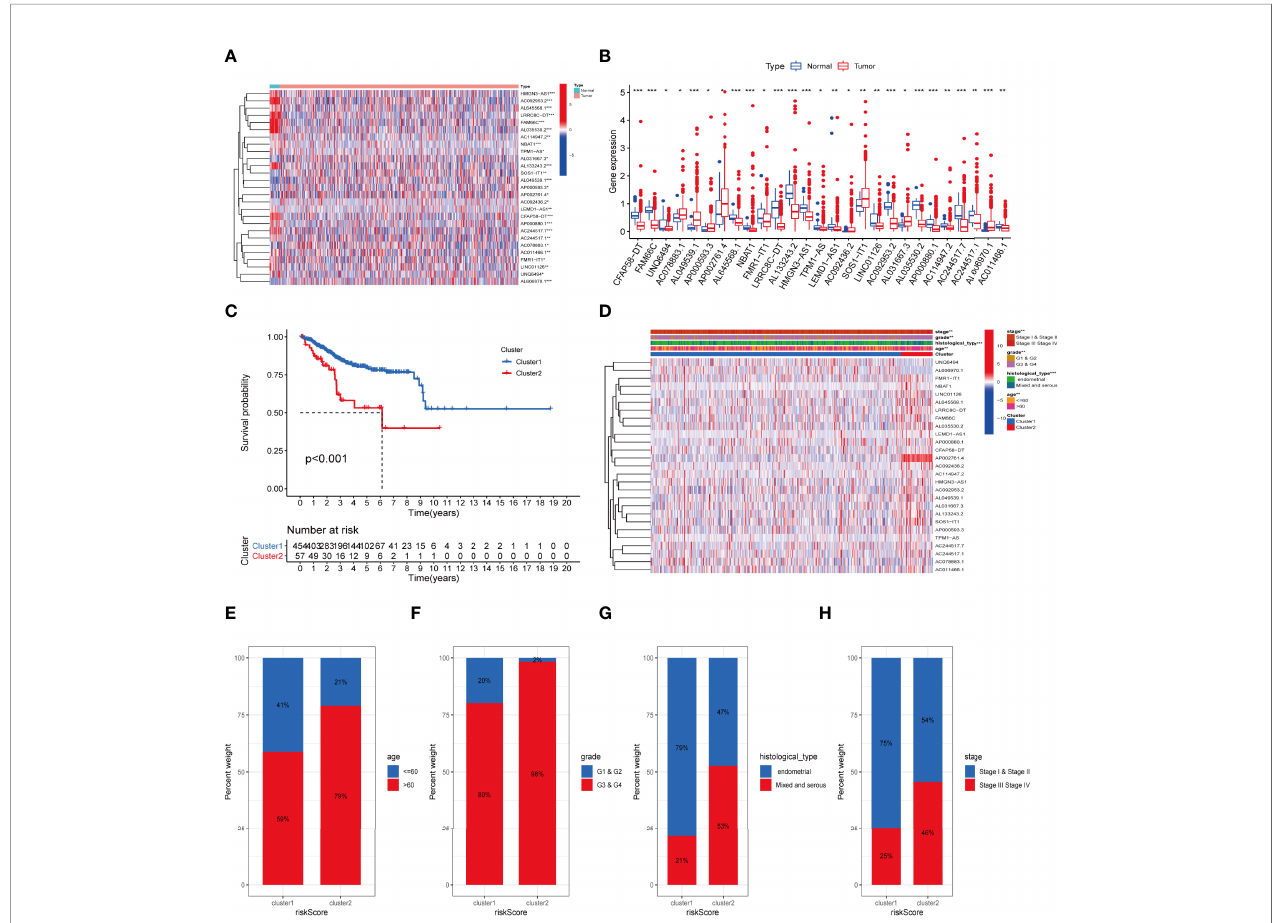
FIGURE 2 | The association between the transcription level of IRLs and clinicopathological and prognostic features of the UCEC patients. (A, B) The transcription levels of 27 differentially expressed IRLs between the tumor and normal samples were visualized by heatmap and boxplot. (C) The overall survival of UCEC patients in the two clusters was calculated by Kaplan-Meier curves. (D) The transcription levels of 27 differentially expressed IRLs between the two clusters with clinical features were shown in heatmap. (E-H) The ratio of different age (E) , grade (F) , histological type (G) , and stage (H) in the groups. *P < 0.05, **P < 0.01, ***P <